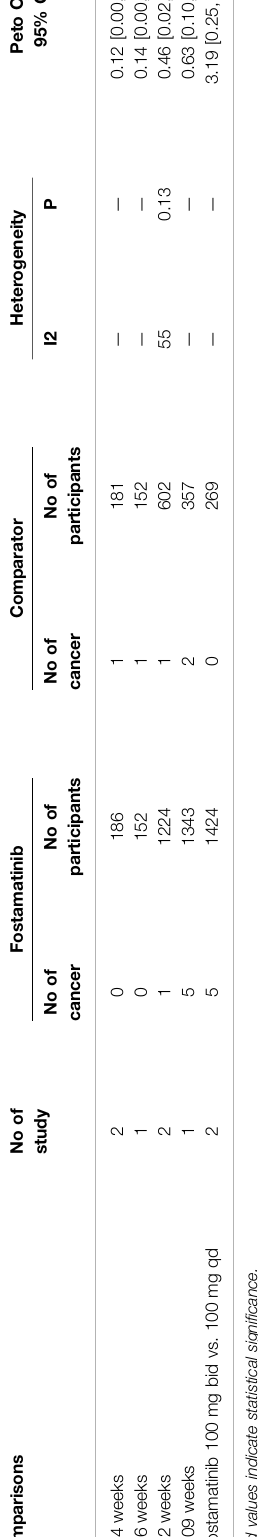
4.33, 95%CI 0.52 – 36.07, 4/1273 vs. 0/613, I 2 = 0, and n = 4) ( Table 2 ; Supplementary Figure S11 ). RA patients who used fostamatinib 100 mg twice daily did not have an increased risk of malignant neoplasms compared to those who used 150 mg of fostamatinib once daily (Peto OR = 0.60, 95%CI 0.08 – 4.81, 2/ 2263 vs. 2/968, I 2 = 50, and n = 5) ( Table 2 ; Supplementary Figure S12 ).